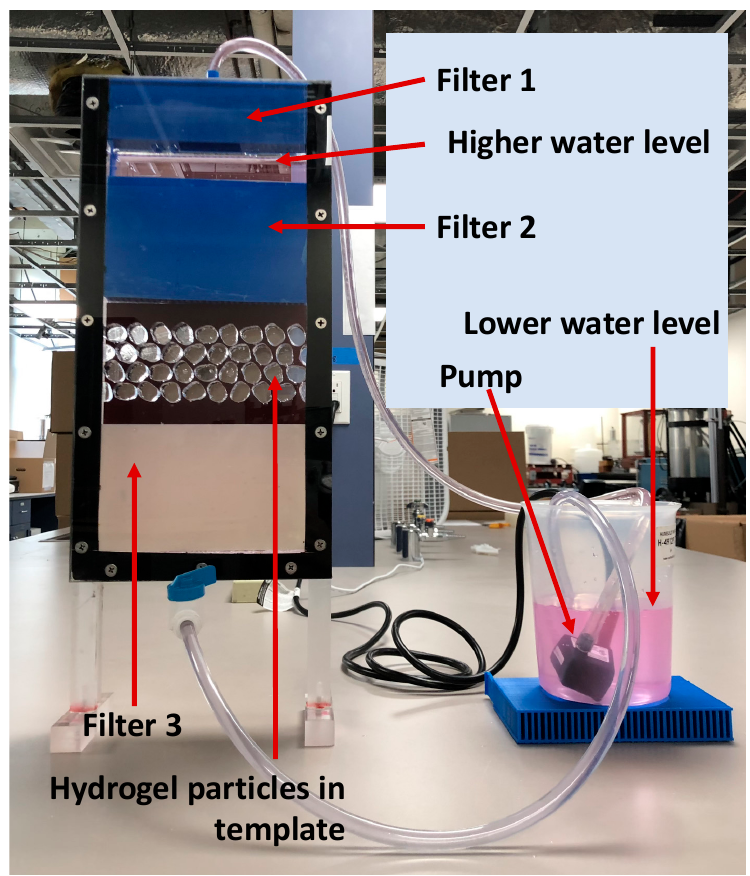
Figure 5. Testing apparatus showing hydrogel particles placed at a fixed porosity and saturating water infused with fluorescent nano particles.